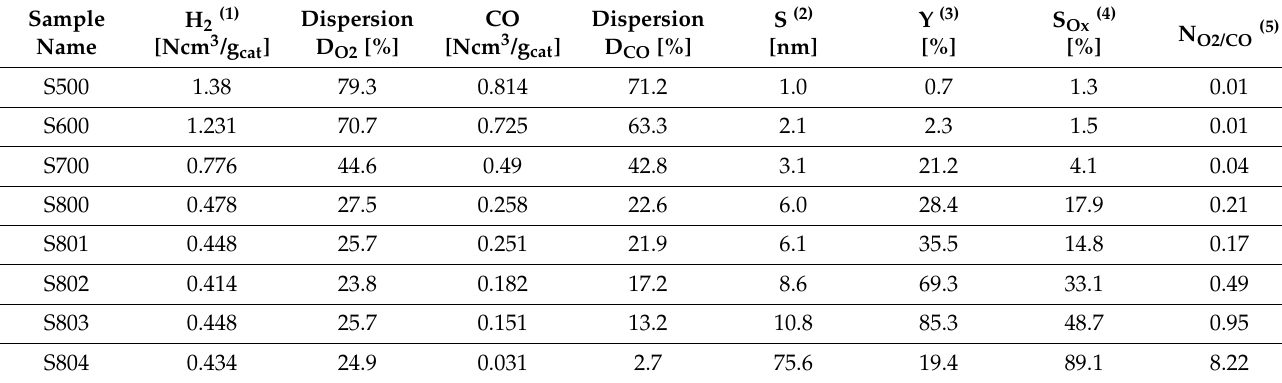
Table 1. Adsorption properties, dispersion rates, and platinum crystallites sizes of the Pt/Al 2 O 3 catalysts.